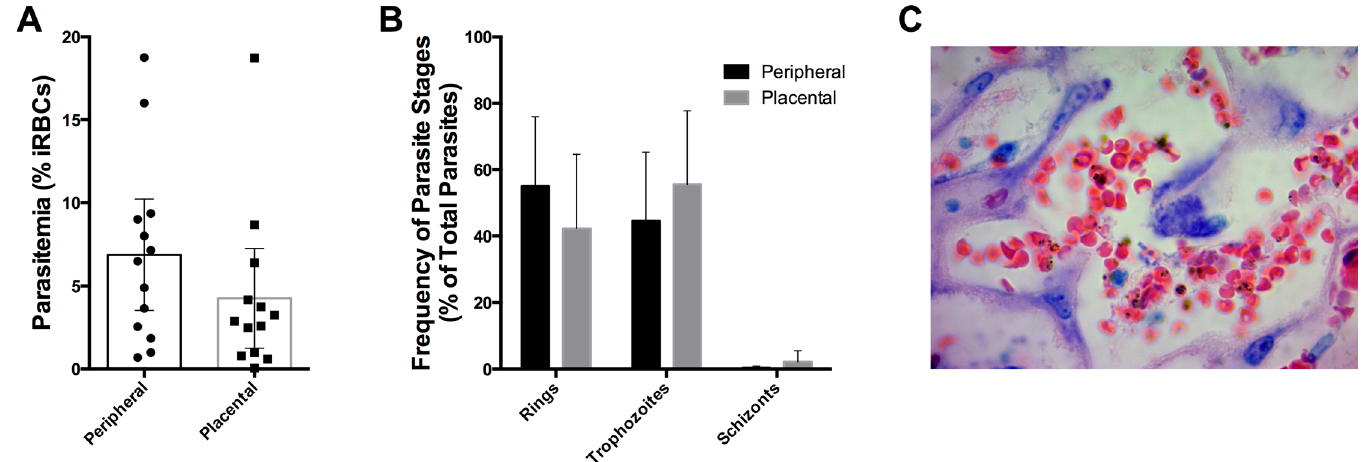
Fig 5. Peripheral and placental parasitemia during P . chabaudi re-infection at gestational day 18. (A) Parasite burden in the peripheral and placental blood of mice 8 days after re-infection with heterologous Pcc- CB iRBCs. (B) Frequency of different parasite stages in the peripheral and placental blood of mice 8 days after re-infection with heterologous Pcc- CB iRBCs. (C) Giemsa-stained placental tissue section from a mouse 8 days after re-infection with heterologous Pcc- CB iRBCs. Data are presented as means with 95% confidence intervals.